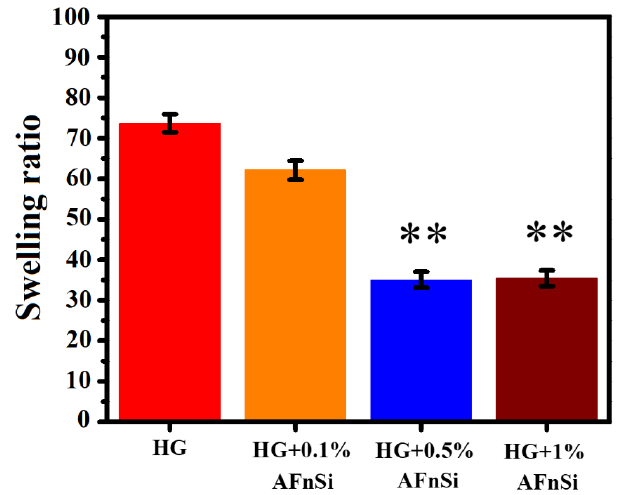
Figure 5. Swelling ratio of HG hydrogel with the different concentrations of AFnSi crosslinker (0, 0.1, 0.5, and 1.0% ( w / v )), respectively. Error bar represents the standard deviation ( ± ; SD), ** p < 0.01 compared with HG hybrid hydrogel alone.